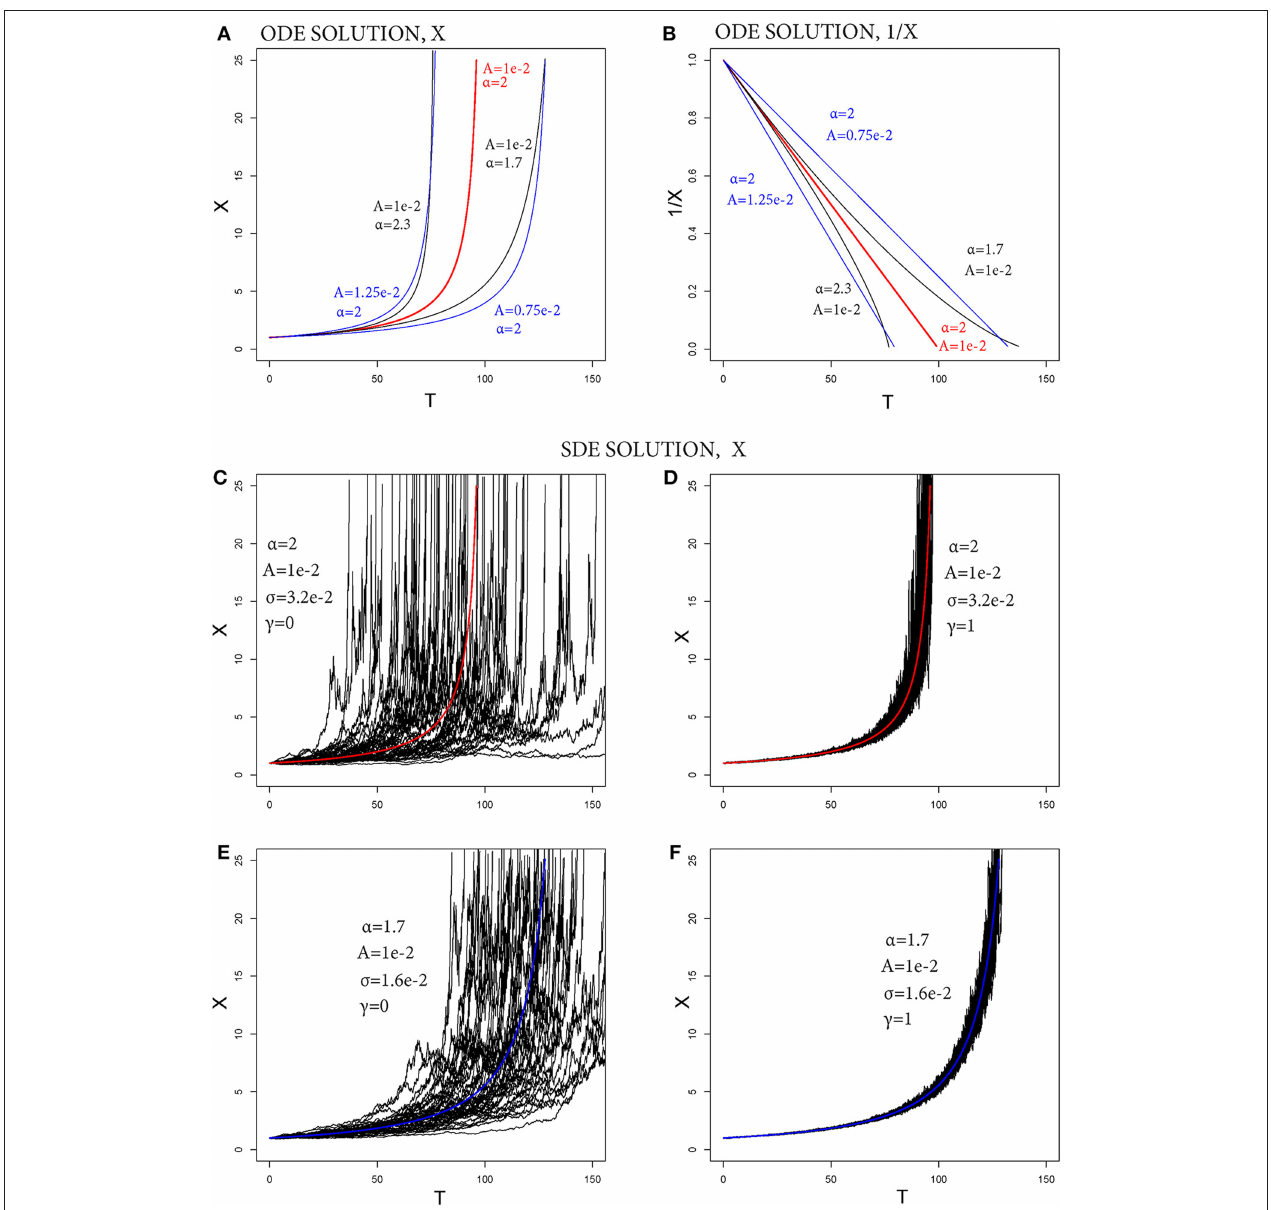
FIGURE 1 | (A,B) Examples of ODE solution of FFM, (A) X, and (B) 1/X. (C–F) Examples of SDE solution of FFM, (C,E) with γ = 0, (D,F) with γ = 1. (C,D) with α = 2, (E,F) with α = 1.7. The colored lines are the ODE solutions, the black lines are 50 random paths of the SDE